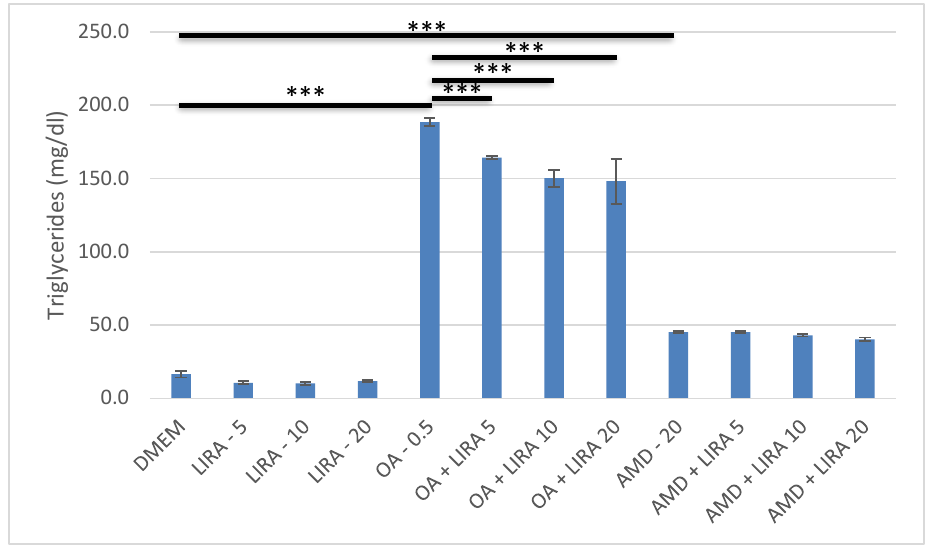
Figure 4. Triglyceride content in DIS and NAS cell culture models, incubated with varying concen- trations of LIRA. One-way ANOVA F (11, 35) = 579.2; p = 2.62 × 10 − 26 post-hoc Tukey HSD. Bars assigned with asterisks are statistically significantly different (*** p < 0.001). The data are shown as the means ± SD (standard deviation) from at least three biological replicates. Dulbecco’s modified Eagle’s medium (DMEM), LIRA (LIRA/nM), oleic acid (OA/mM), amiodarone (AMD/ µ M).